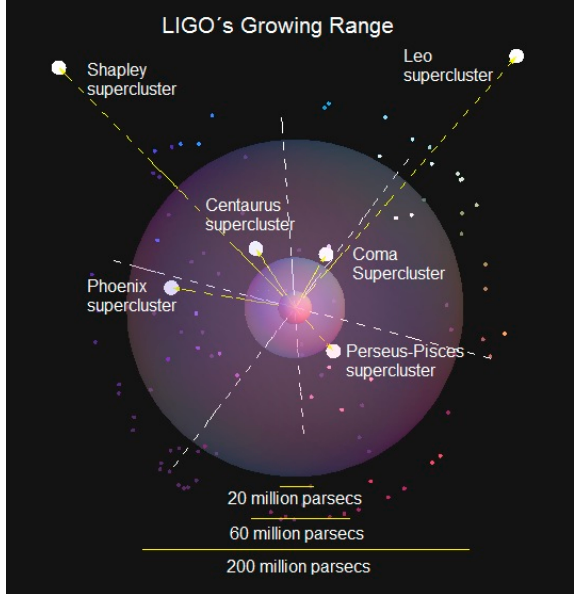
Figure 14. Showing the initial range of LIGO and the anticipated range of aLIGO. The volume is much greater and the anticipated rate of events and detections are expected to scale up with the volume. Note the large number of galaxies included in the observational volume. The anticipated factor of 3 in sensitivity should correspondingly increase the event rate by up to nine times.